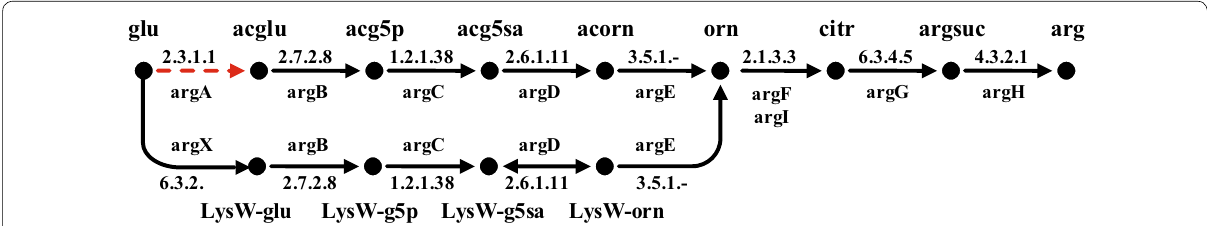
Fig. 3 The arginine biosynthesis pathways in the strain SCM1 model. Genes for the first reaction (EC 2.3.1.1) in the normal arginine synthesis pathway (up part) is missing in the genome and thus a gap exists in the pathway. The existence of gene Nmar_1288 encoding ArgX that catalyzes the first step of the LysW-mediated arginine pathway (bottom part) suggests that strain SCM1 uses this pathway for arginine synthesis. Glu: l -glutamate; acglu: N -acetyl- l -glutamate; acg5p: N -acetyl- l -glutamate 5-phosphate; acg5sa: N -acetyl- l -glutamate 5-semialdehyde; acorn: N -acetylornithine; orn: l -ornithine; citr: l -citrulline; argsuc: N -( l -Arginino) succinate; arg: l -arginine; lysW-glu: LysW- l -glutamate; lysW-g5p: LysW- l -glutamyl 5-phosphate; lysW-g5sa: LysW- l -glutamate 5-semialdehyde; lysW-orn: LysW- l -ornithine